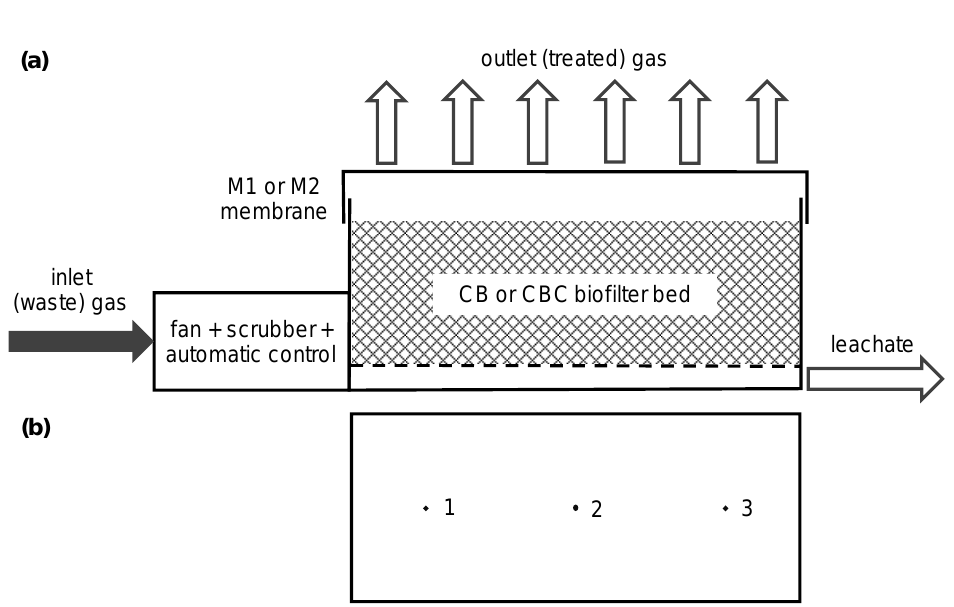
Figure 1. ( a ) Scheme of the pilot-scale combined biofilter equipped with a fan, a scrubber, an automatic regulation and control unit, and an installation for the distribution of waste gas and leachate drainage. Biofilter bed materials (CB—mix of stumpwood chips and pine bark; CBC—mix of stumpwood chips, pine bark, and compost from green waste) and membranes (M1 or M2) were tested alternatively. ( b ) Location of sampling points (1, 2, 3) of treated gases above the biofilter bed and the membranes—top view.